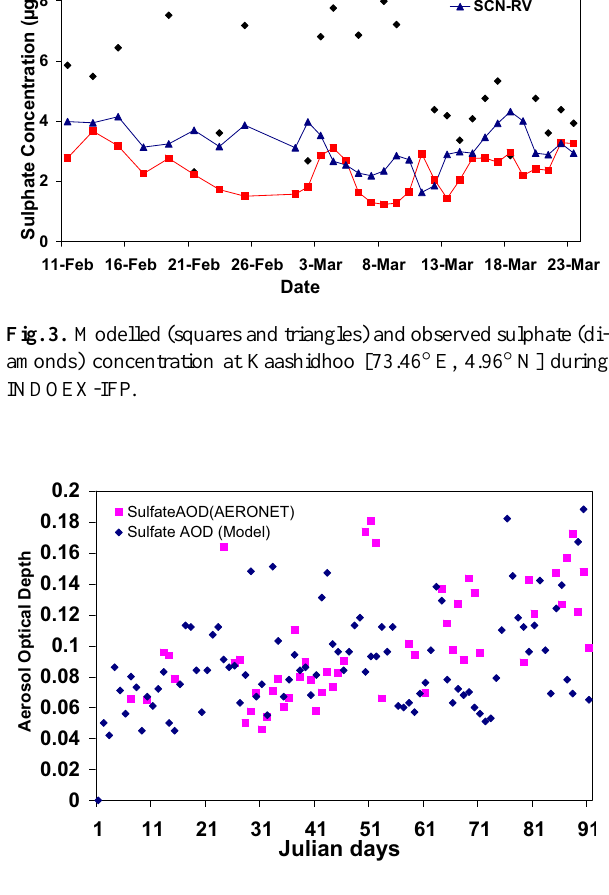
Fig. 4. Modelled and observed sulphate aerosol optical depth for the period January–March 1999 at Kaashidhoo [73.46 ◦ E, 4.96 ◦ N]. The observed AOD is obtained as 29% of the AERONET observed AOD. Note that rest of the figures are from SCN-RV except other- wise mentioned.